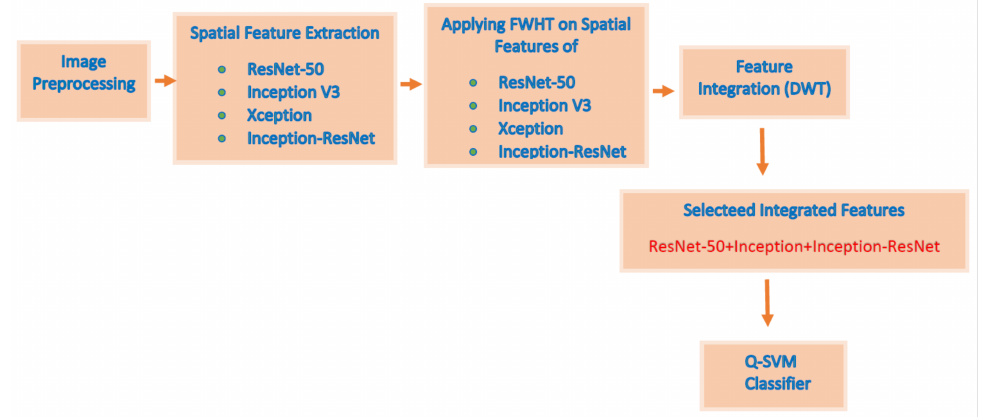
Figure 6. The final architecture of DIAROP diagnostic tool.